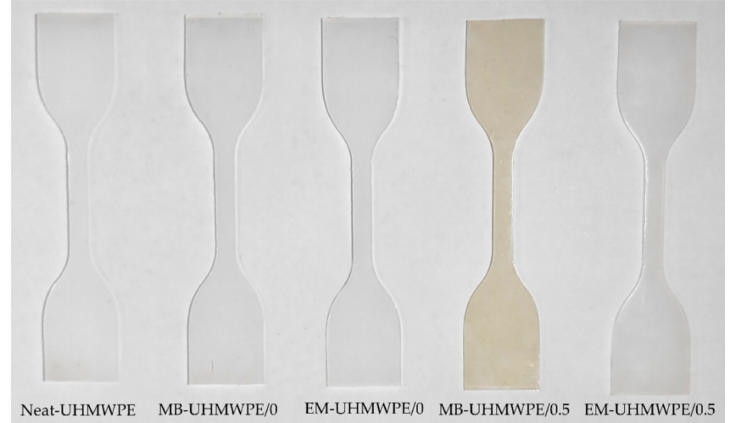
Figure 5. The visual appearance of polymer and UHMWPE/CNF bionanocomposites samples produced through melt blending and ethanol